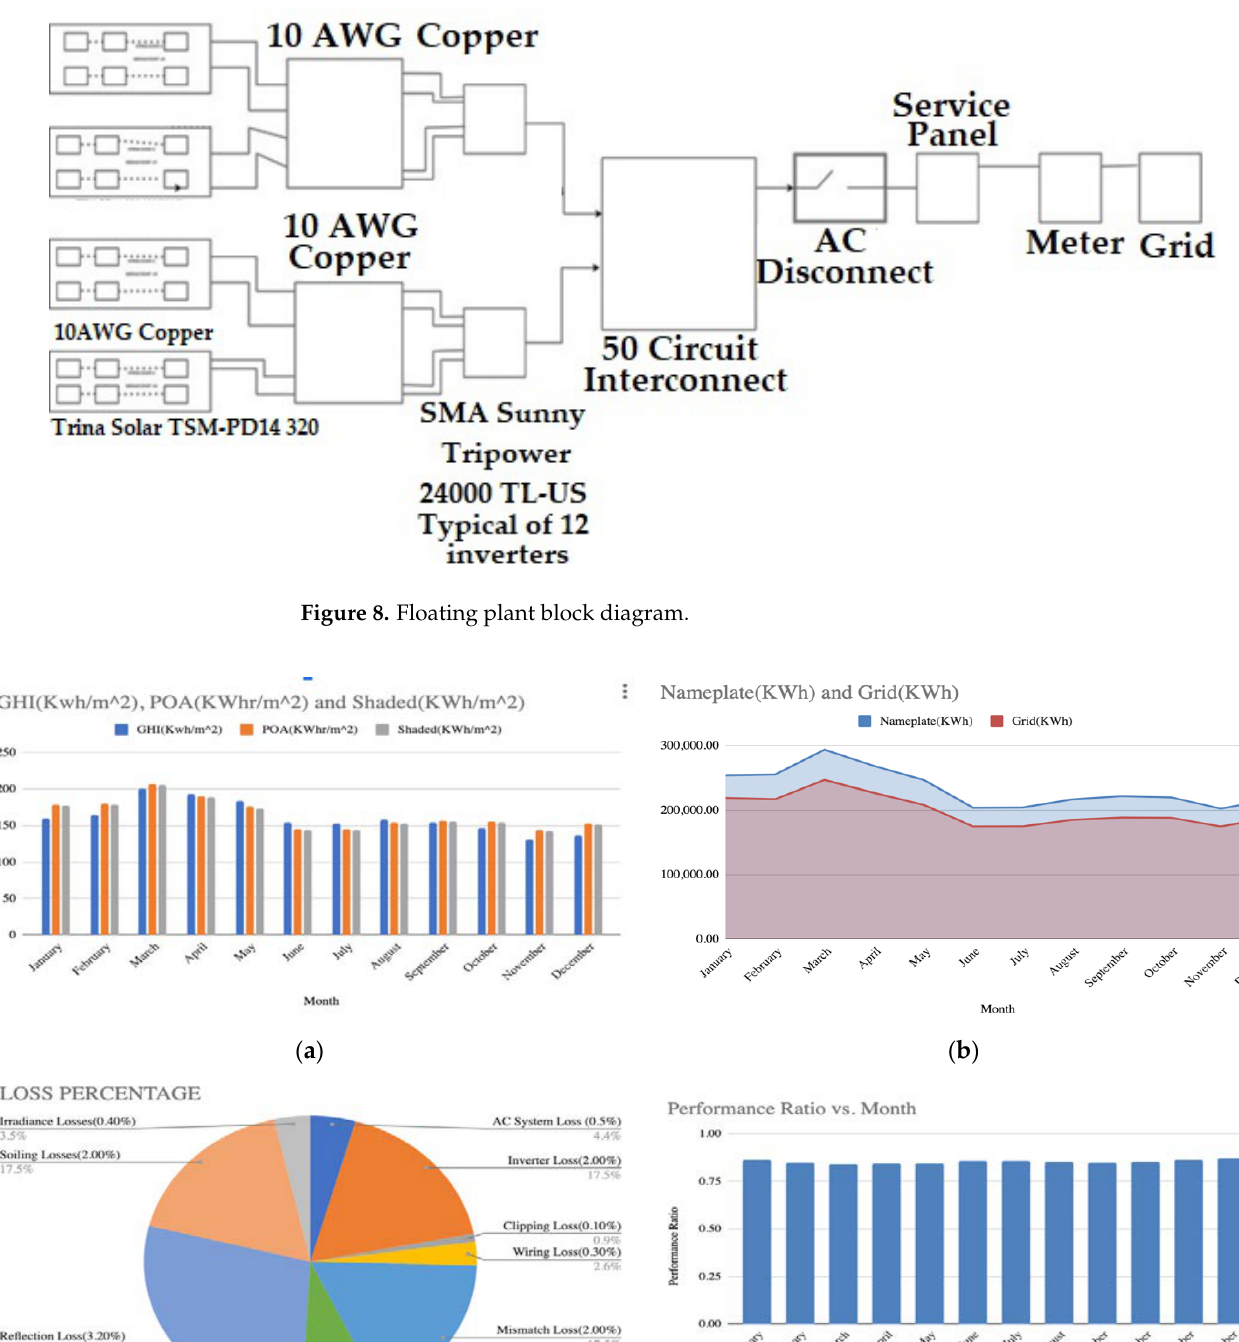
Figure 9. ( a ) GHI, POA and shaded radiation; ( b ) nameplate energy and grid energy; ( c ) loss % age; and ( d ) performance ratio.